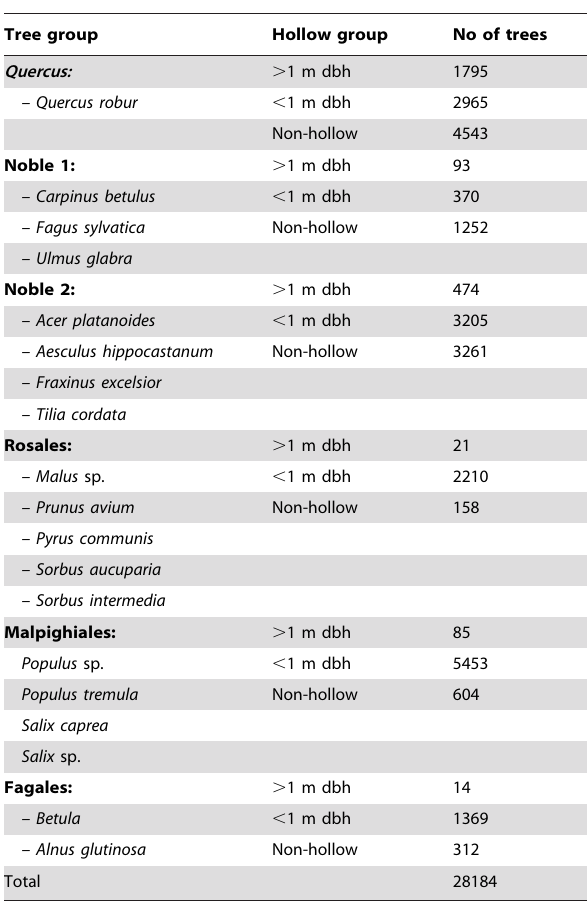
Table 1. Categorization of trees in the